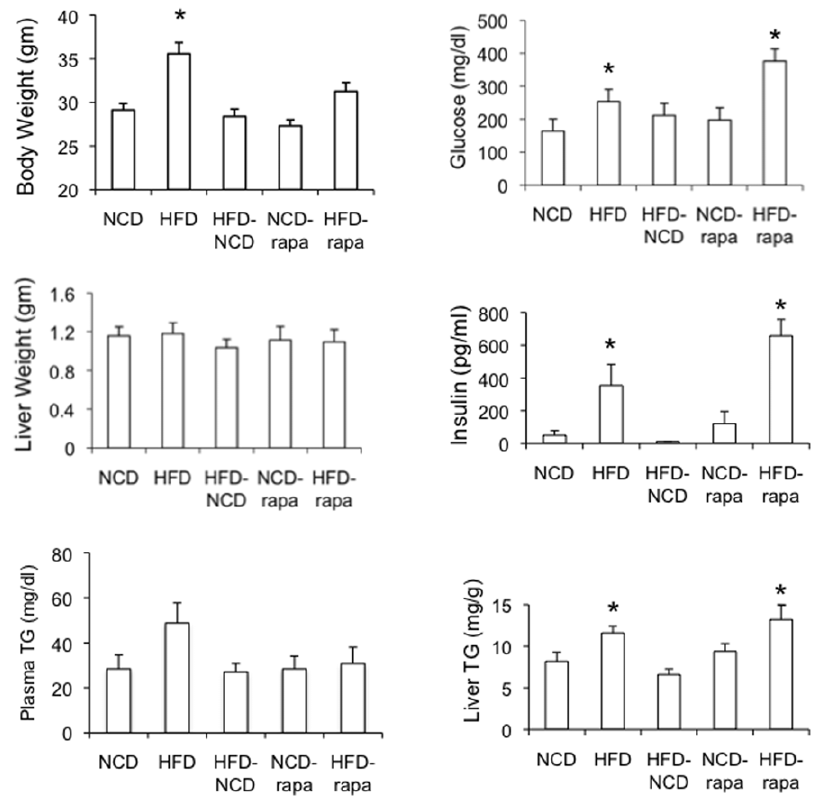
Figure 4. Metabolic response to rapamycin following HFD. Six-week old, wild-type mice were randomly assigned to one of 5 groups with n=5 in each group (see text). At the end of 6 weeks, mice were fasted overnight and sacrificed. Shown are the results of body and liver weights, fasting serum glucose and insulin, plasma and hepatic triglyceride levels for each group. Values represent mean 6 SEM. * associated with HFD indicates p , 0.05 with respect to NCD group. * associated with HFD-rapamycin group indicates p , 0.05 with respect to NCD-rapamycin group. NCD, normal chow diet; HFD, high-fat diet; Rapa, rapamycin.